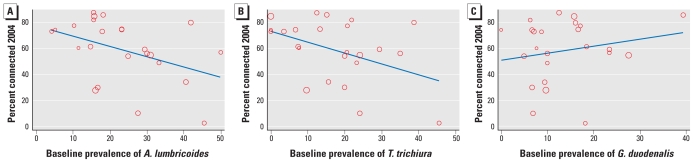
Proportion of households connected to Bahia Azul program sewers in 2004 and baseline (1998) prevalence of (A) A. lumbricoides, (B) T. trichiura, and (C) G. duodenalis by sentinel area; 1,657 children 0–4 years of age, Salvador, Brazil. Each point represents the estimate for a sentinel area, and its size reflects the number of households in that area. The line on each graph is fitted by bivariate linear regression, weighted by the number of households in each sentinel area.